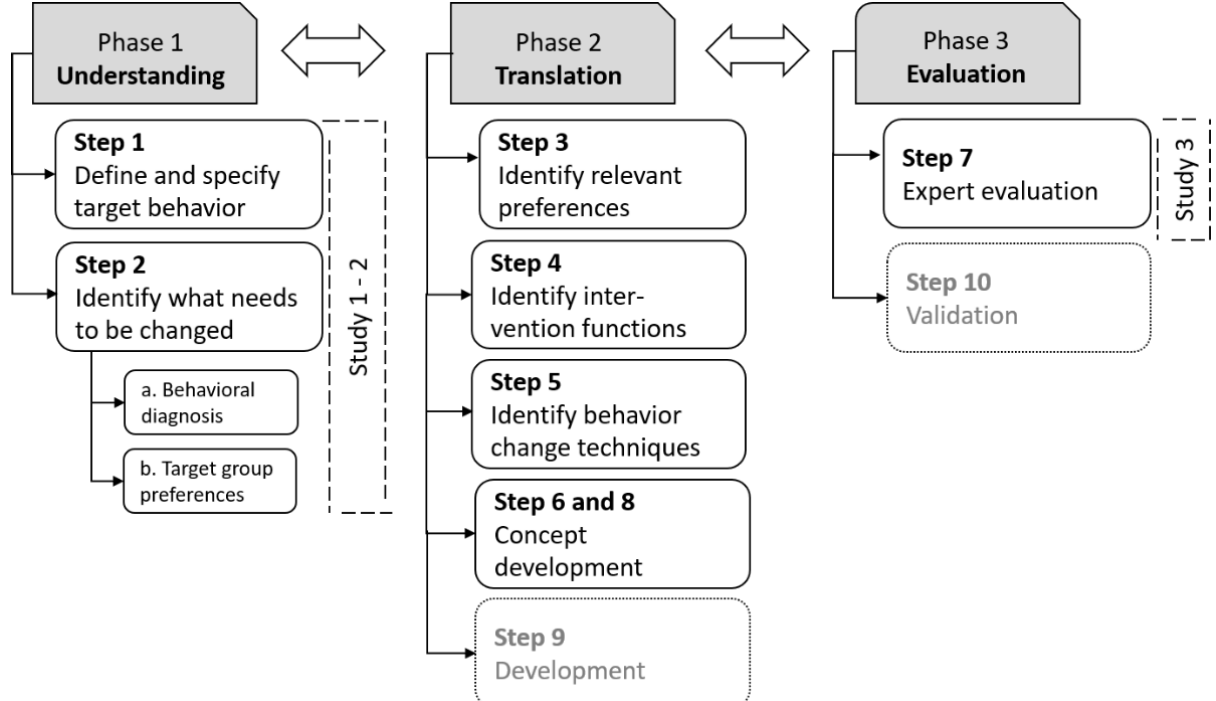
Figure 1. Systematic design process of the dietary mobile app for adolescents and young adults. Steps 1-7 (in black font) are discussed in the text; steps 9 and 10 (in grey font) are being or will be carried